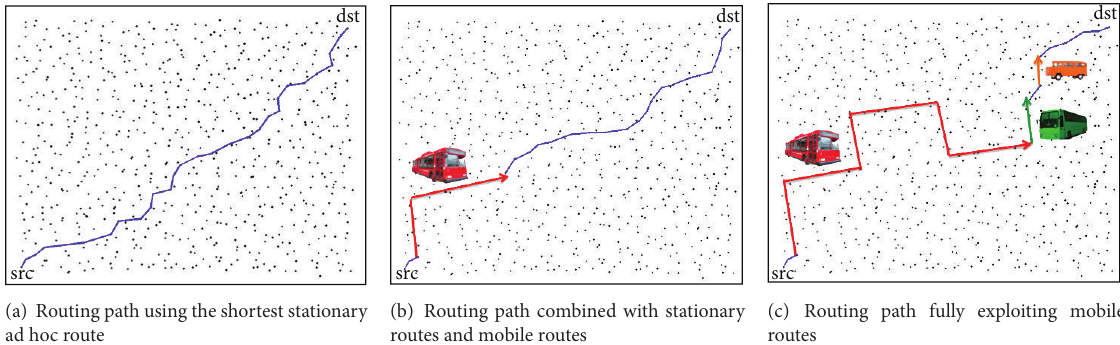
Figure 1: Routing paths from stationary source (in the left bottom) to stationary destination (in the right top) in the usages of stationary and mobile paths. Routing cost and packet deadline constraint determine which routing path should be selected for effective data